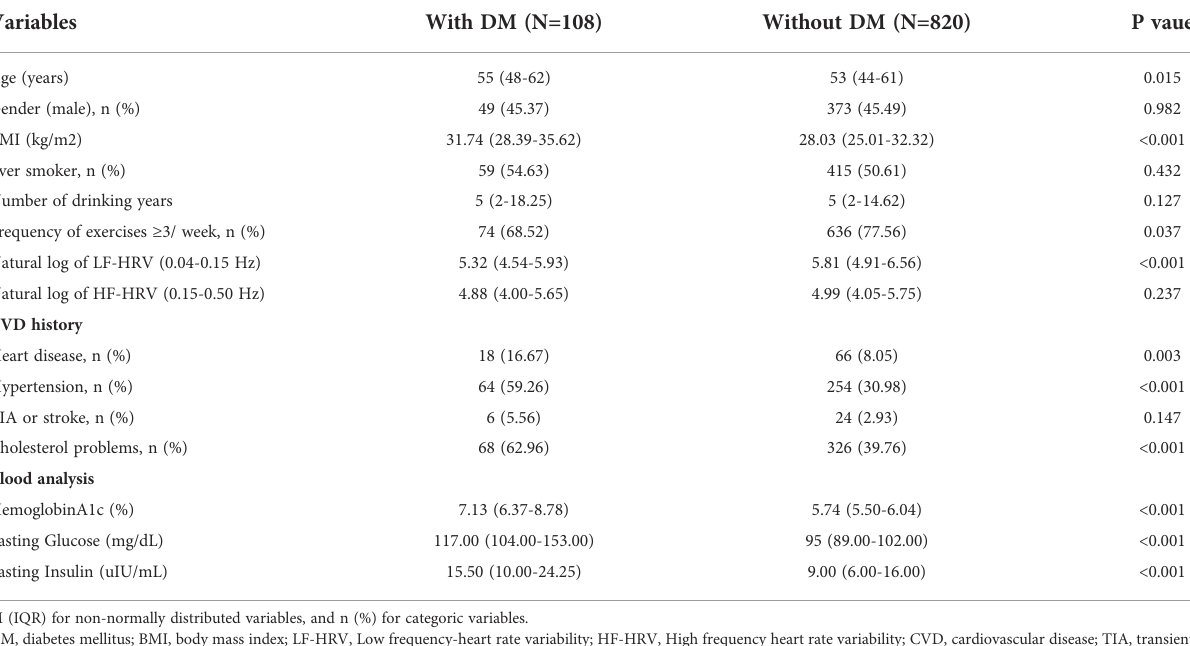
TABLE 1 Characteristics of participants (N=928).